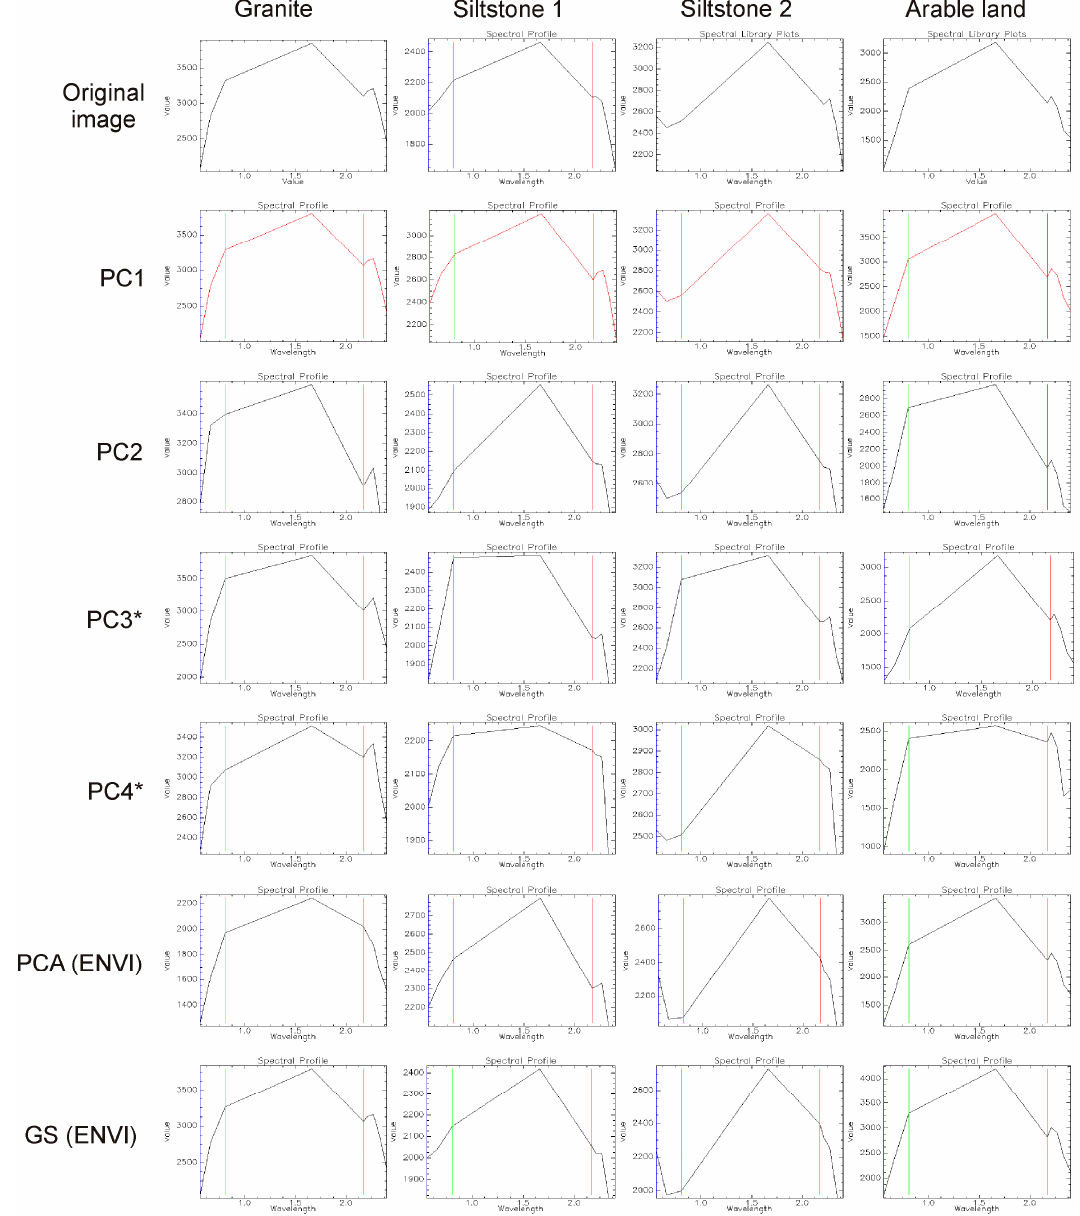
Figure 9. Comparison of the spectral curves of the test sites from each image in the 0.5-m spatial resolution of the ASTER sharpened image. PC1–PC4 refer to sharpened images using the respective PCs for a PAN substitution, GS refers to the Gram–Schmidt sharpening algorithm. It was expected that the first two PCs have the potential to give good results when employing the PCA sharpening process, however PC3* and PC4* were used to compare the result and explain it in a wider context.